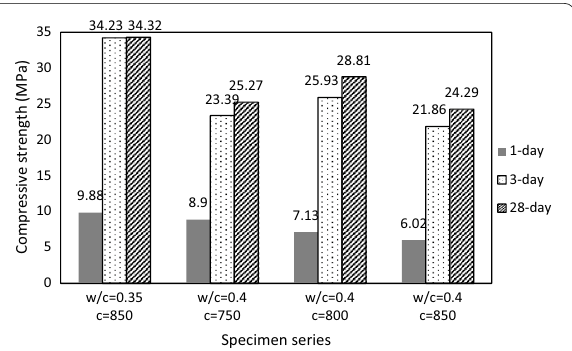
Fig. 10 Compressive strength of mortars at three ages.